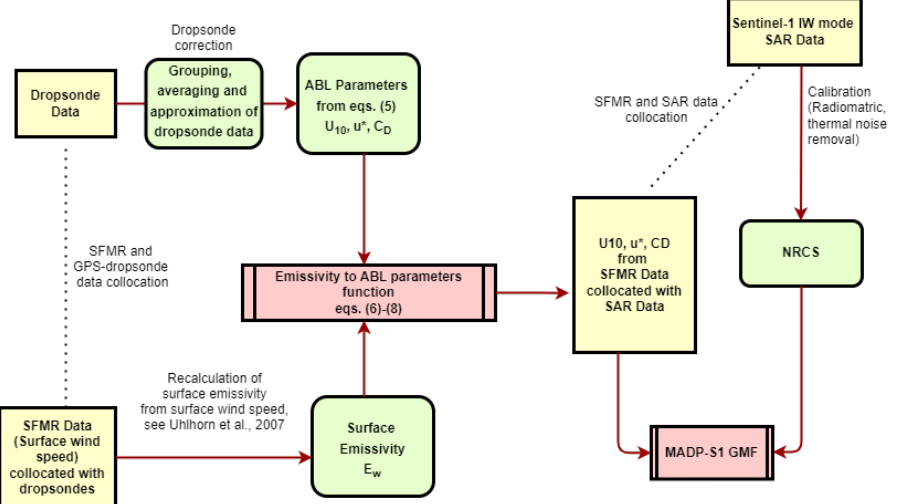
Figure 4. Flowchart diagram showing all analysis steps and their connections made to obtain the MADP-S1 GMF.